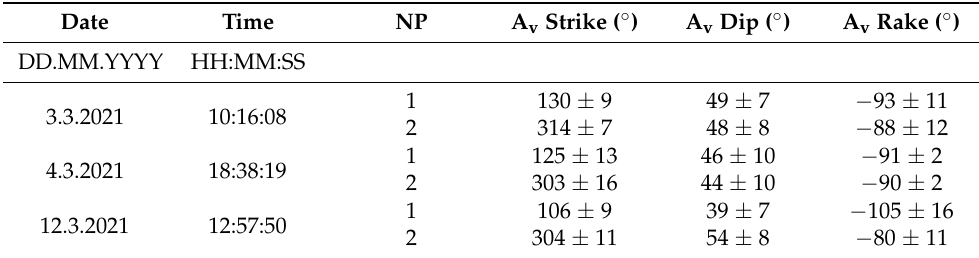
Table 4. Average (A v ) geometric features of the nodal planes (NPs) determined in fault-plane solutions produced by several national and international seismological centers (see Table S2) for the three strong